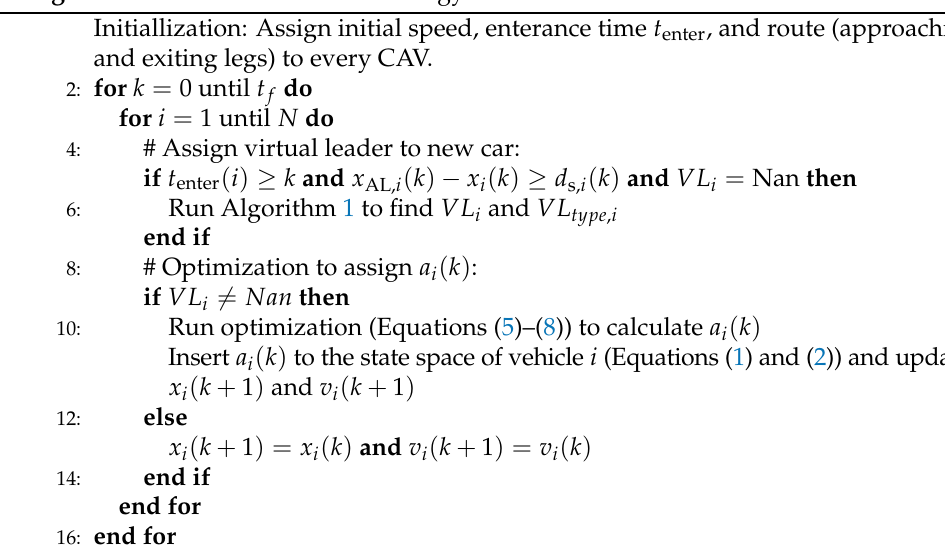
Algorithm 2: Overview of methodology